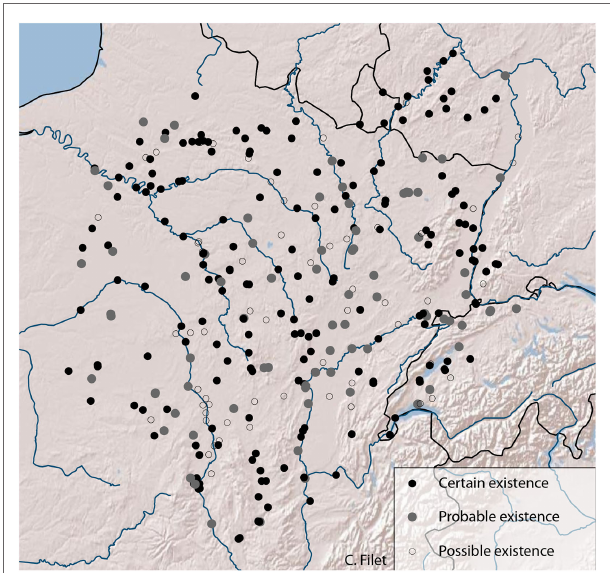
FiGUre 1 | inventory of grouped habitats from 1 ha in the studied area . Created by author (Basemap: Copyright © 2017 Esri. All rights